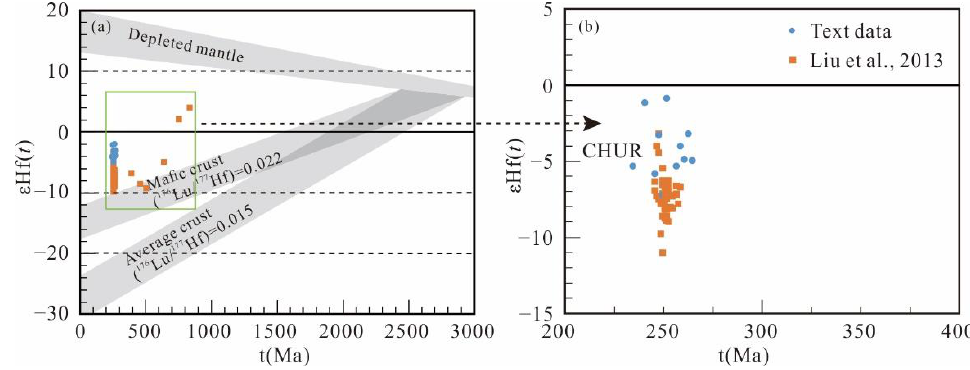
Figure 7. εHf( t ) versus age diagram ( a , b ) (Base image according to [64]). The samples from Liu et al. [65] are volcanic rocks along the Ailaoshan orogenic belt. Lu-Hf isotopic data of 12 zircons from sample LWZ-02 (granite porphyry) are shown in Supplementary Table S3. f Lu/Hf ratios ranged from − 0.92 to − 0.96, and ε Hf( t ) varied from − 0.97 to +4.08 with an average value of +1.21 (Figure 8a,b). The variation from negative value to positive values indicated that the rocks could be composed of heterogeneous zircons. Zircon single-stage Hf model ages (T DM ) ranged from 739 Ma to 945 Ma, and two-stage Hf model ages (T DMC ) ranged from 1336 Ma to 1795 Ma.